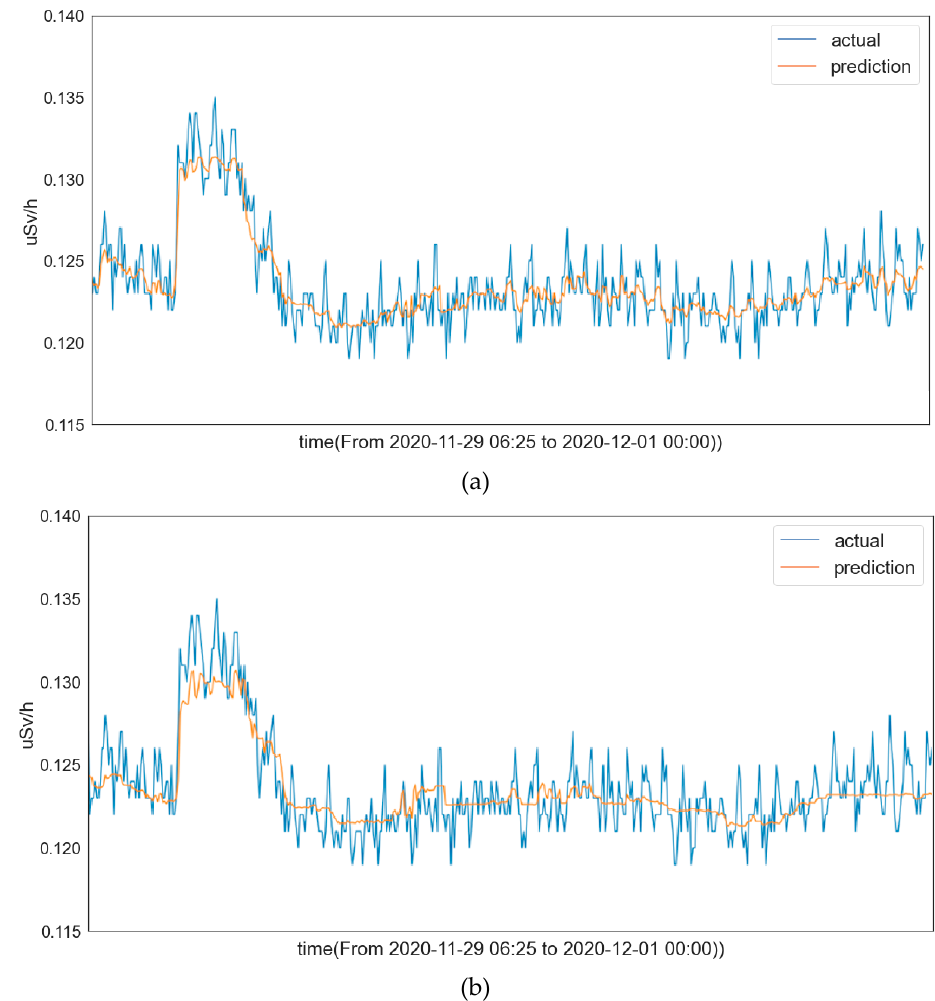
Figure 6. ( a ) Prediction curve of the LightGBM learning model with standardization preprocessing; ( b ) prediction curve of the LightGBM learning model with normalization preprocessing.